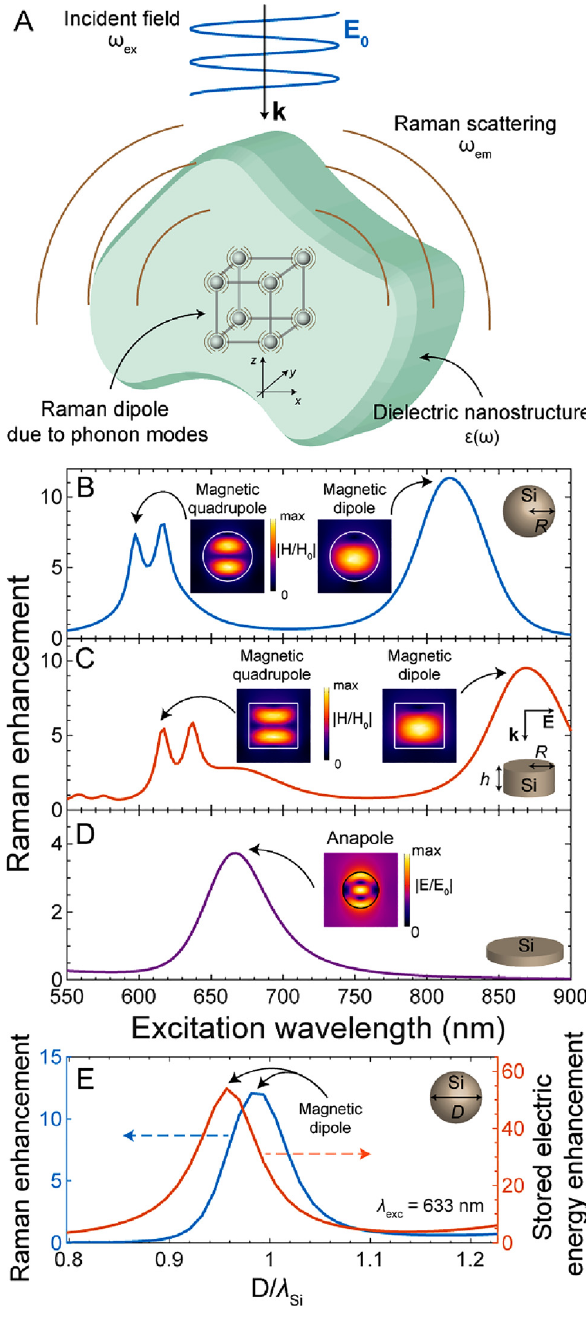
Figure 2: Simulated Raman enhancements. (A) Schematic of inelastic Raman scattering in dielectric nanostructures. The incident field with frequency ω ex excites the phonon mode, which subsequently emits light at the Stokes-shifted frequency ω em . (B – D) Simulated Raman enhancement as a function of excitation wavelength in different silicon nanostructures. The insets show the fi eld pro fi les of the Raman-enhancing resonances supported by the nanostructures. The particle sizes are R = 110 nm, ( R , h ) = (110, 200) nm, and ( R , h ) = (170, 50) nm, respectively. (E) Raman and stored electric energy enhancements in silicon nanospheres of varying diameter at a fi xed excitation